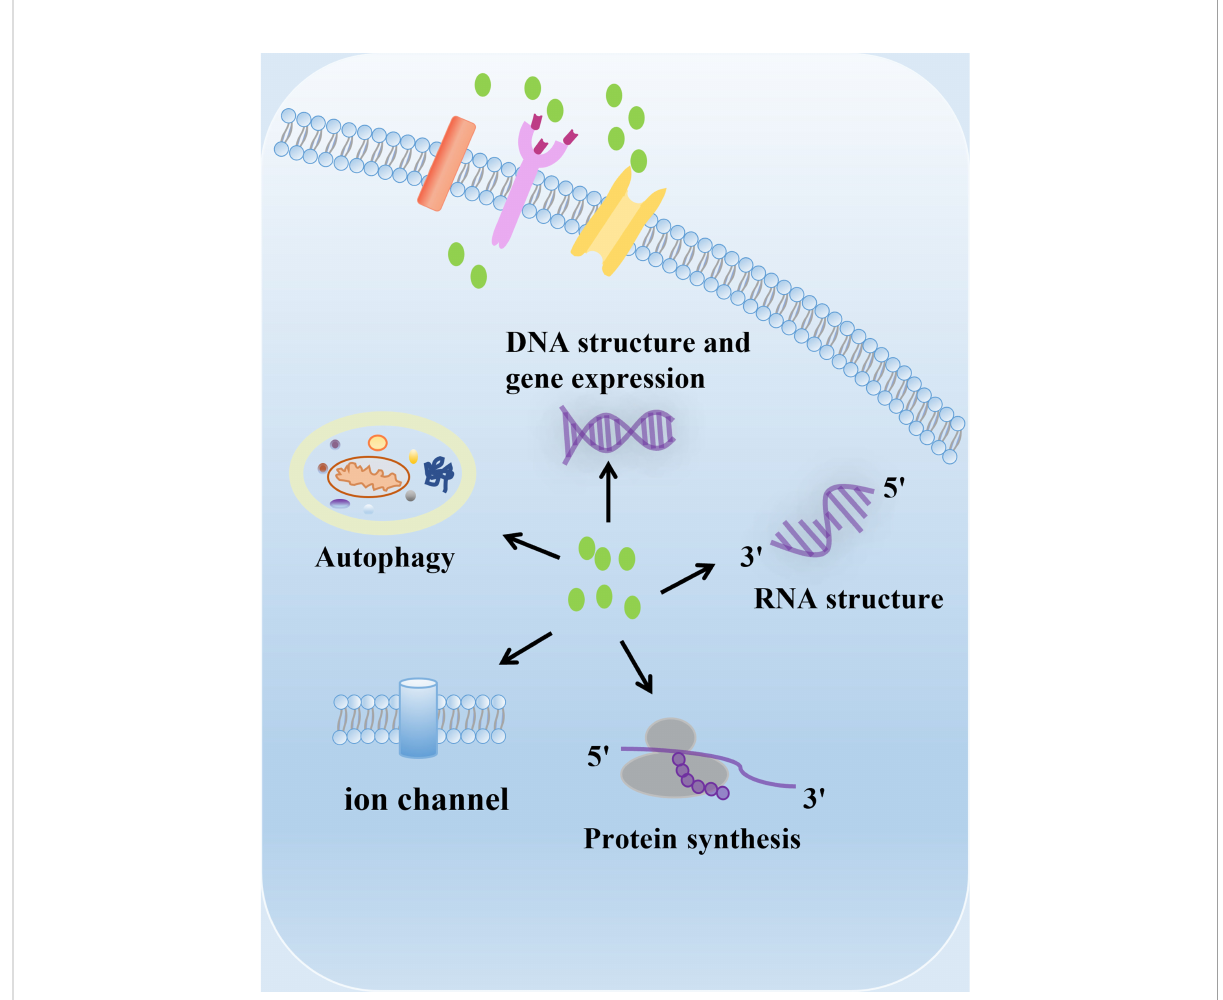
FIGURE 1 The biological function of polyamines. Polyamines have multiple roles in cells, including regulation of gene expression, RNA structure, protein synthesis, ion channel fl ux, and autophagy. Polyamines are required for growth and play important roles in a variety of physiological processes, including immunity, aging, hair growth, and wound